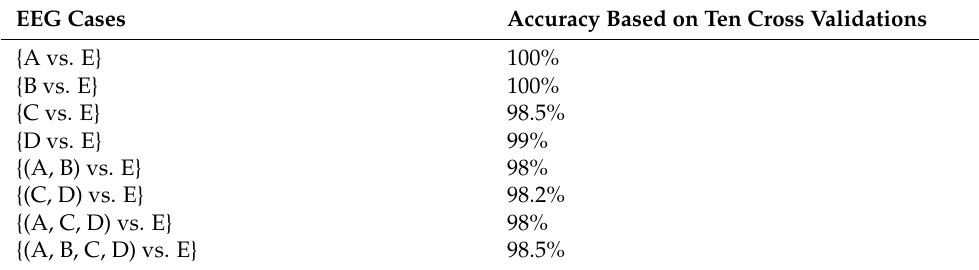
Table 8. Classification accuracy for each EEG Case.